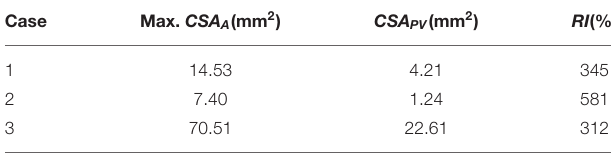
TABLE 2 | Morphological analysis for each case, where